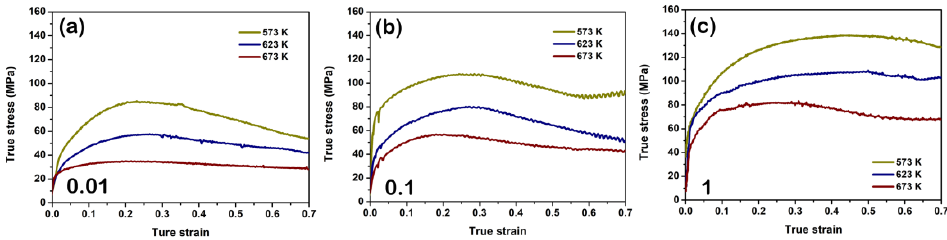
Figure 3. True compressive stress–strain curves at strain rates: ( a ) 0.01 s − 1 ; ( b ) 0.1 s − 1 ; ( c ) 1 s − 1 .